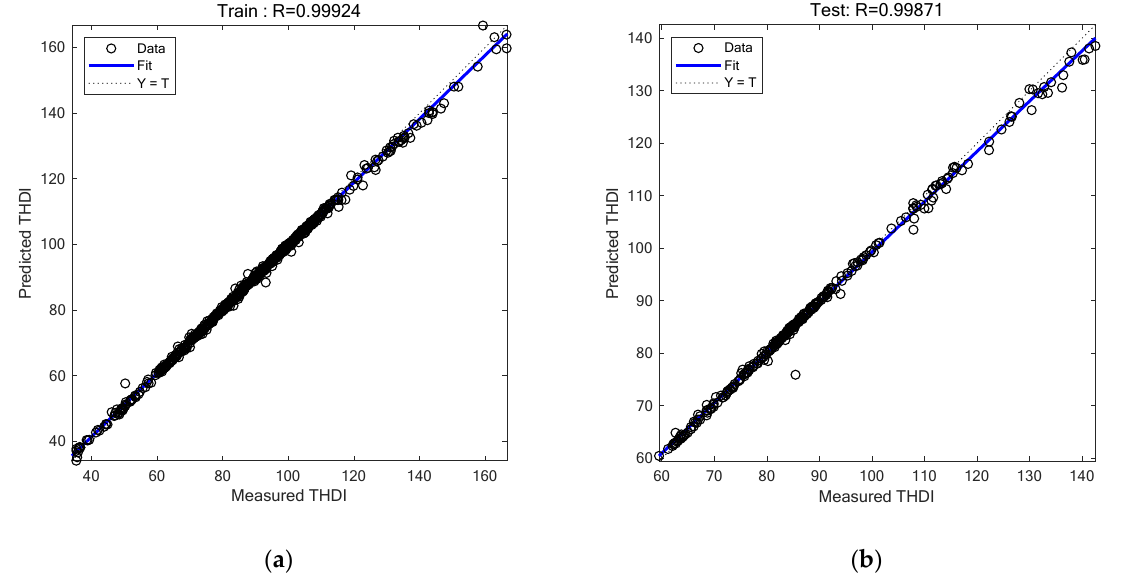
Figure 14. The regression coefficients for training data ( a ) and testing data ( b ) for the following parameters: nMax = 16, maxL = 6, α = 0.5, m = 5, and pTrain = 70%.